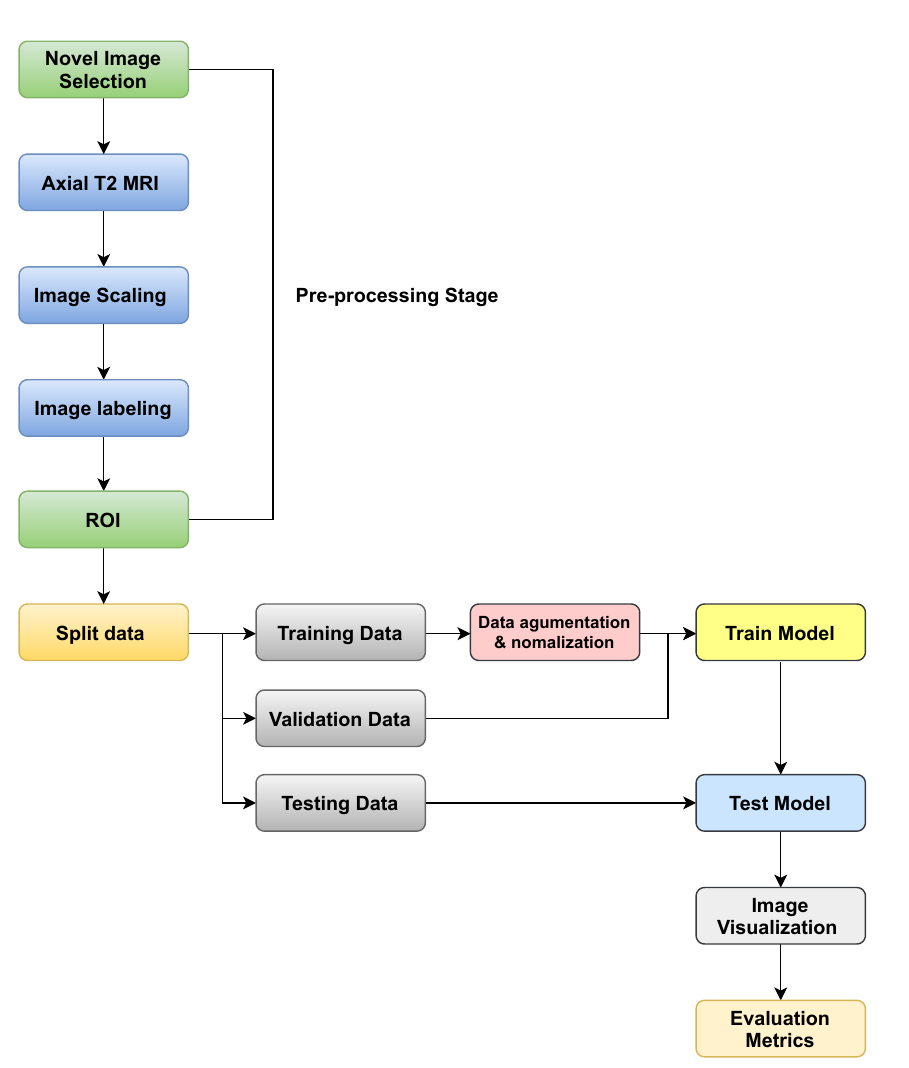
Figure 10. General workflow of the proposed